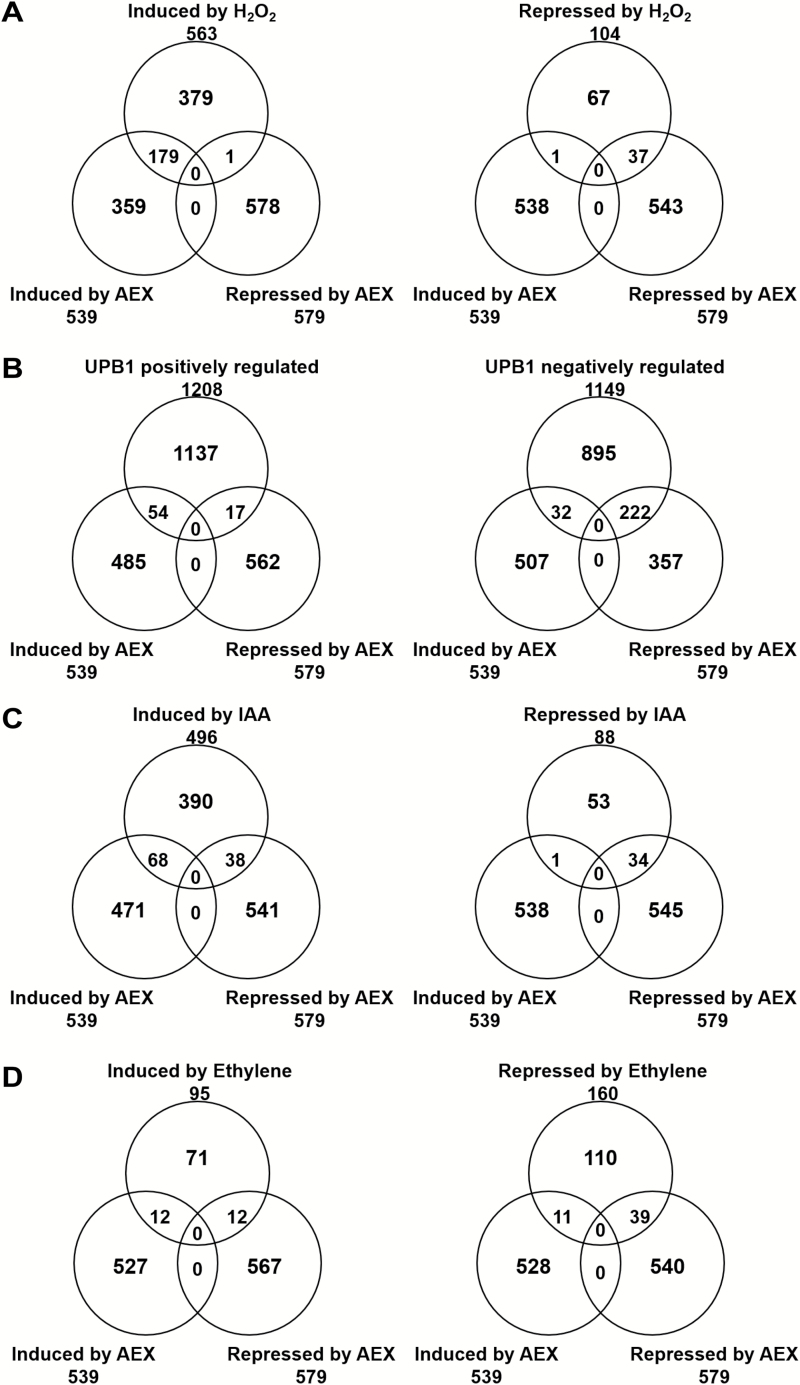
Changes in global gene expression upon short-term AEX treatment. Venn diagrams showing the overlap between transcript dynamics upon AEX treatment (from microarray analysis performed on three independent biological repeats) and published microarray data. Details in Supplementary Tables S2–S5. (A) Induced/suppressed by AEX and H2O2; the transcriptional profile (>2-fold) of 5-day-old light-grown Col-0 plants treated with H2O2 (20 mM, 1 h) was from Davletova et al. (2005). (B) Induced/suppressed by AEX and UPBEAT1 (UPB1) transcription factor; transcriptional profile of UPB1 regulated genes was from Tsukagoshi et al. (2010). (C) Induced/suppressed by AEX and IAA; transcriptional profiles of IAA regulated genes were from Zhao et al. (2003), Okushima et al. (2005a), and Nemhauser et al. (2006). (D) Induced/suppressed by AEX and ethylene; transcriptional profiles of ethylene regulated genes were from Alonso et al. (2003) and Olmedo et al. (2006).